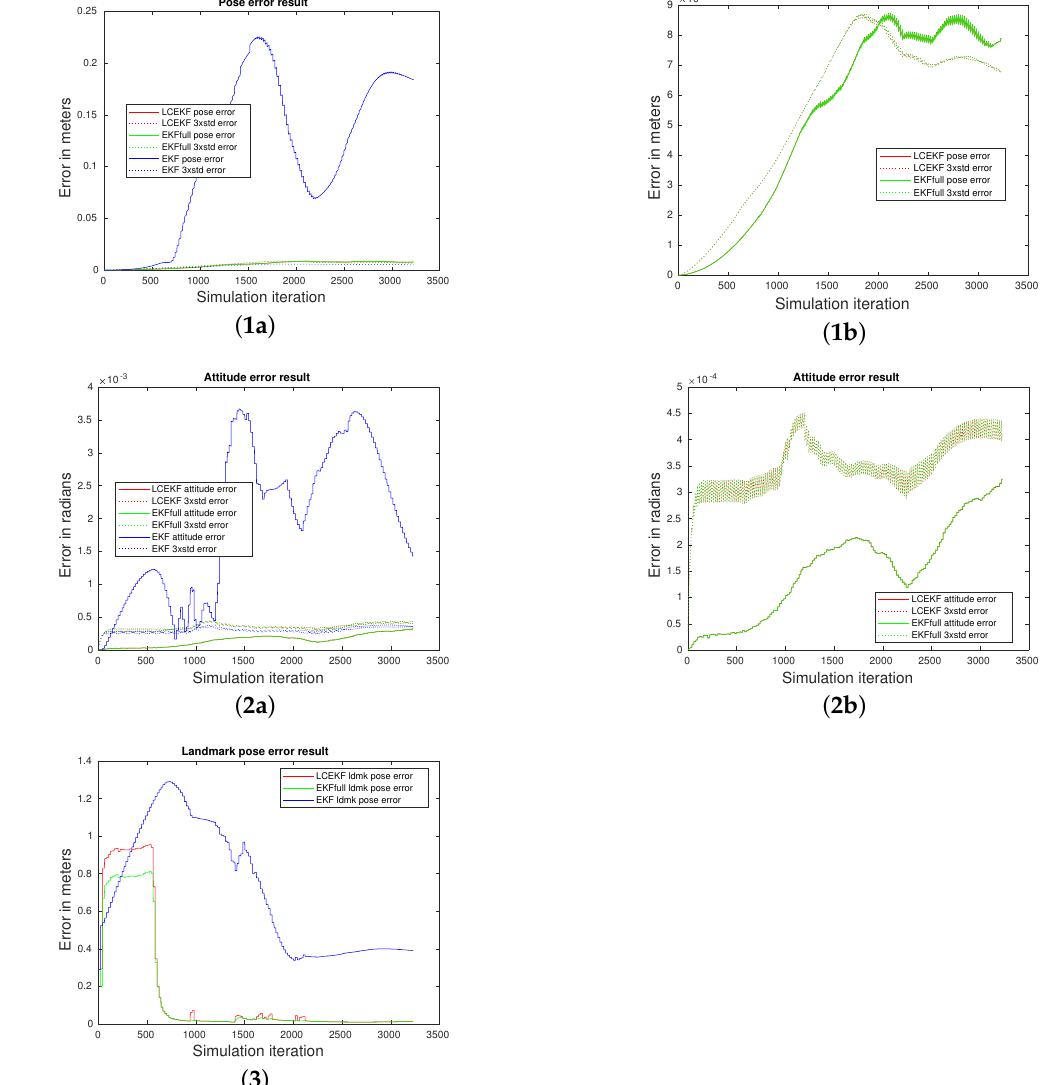
Figure 7. SLAM with sinusoidal noise (Case iii): methods’ comparison. Figures ( 1a ) and ( 2a ) represent the MSE of the pose and attitude estimation over 100 executions for the three methods. As the EKF results hide the two other, the same results without the EKF are presented in Figures ( 1b ) and ( 2b ). Full lines are the mean of the estimation, and dot lines represent the 3 sigma value. Figure ( 3 ) represents the MSE of the landmark convergence during the